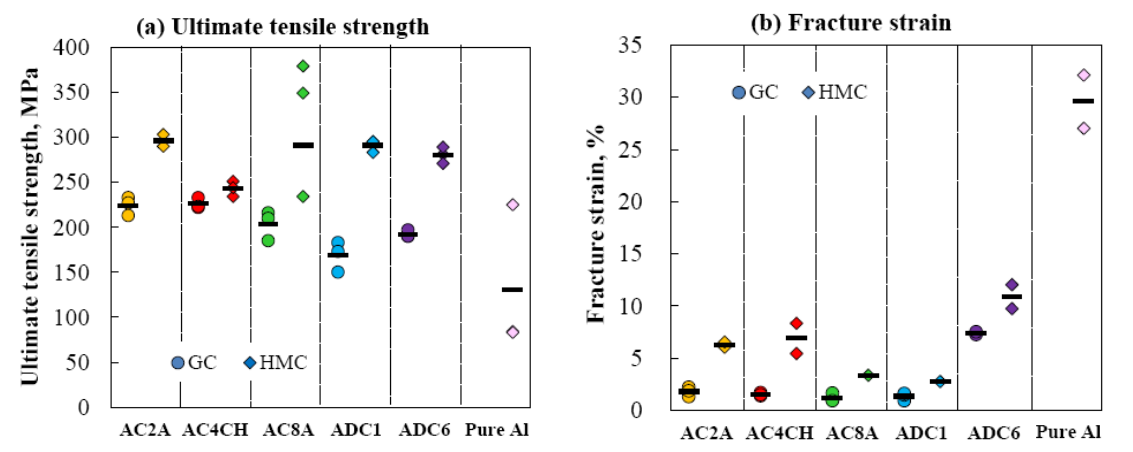
Figure 6. Tensile properties of cast aluminum alloys: ( a ) ultimate tensile strength and ( b ) fracture strain.